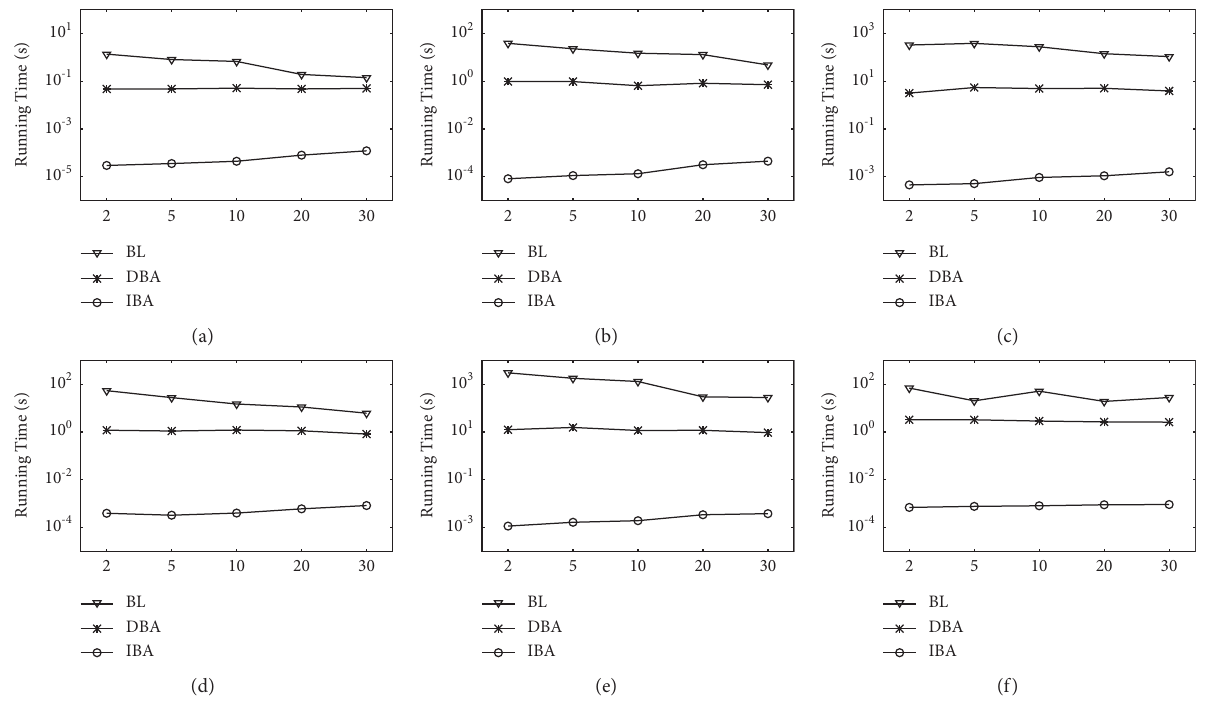
Figure 4: Experiment results by varying number of query vertices | Q | : (a) Email-Eu-core, (b) Facebook, (c) Email-Enron, (d) Brightkite, (e) Gowalla, and (f) YouTube.